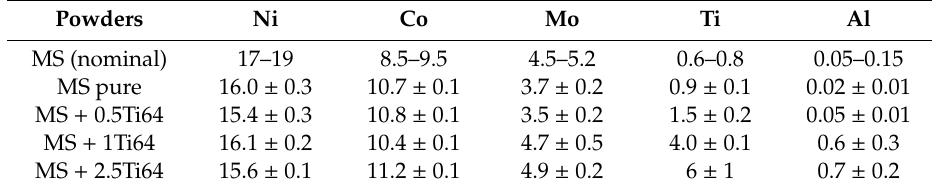
Table 1. Comparison of wt.% concentrations (mean values and standard deviations) of major